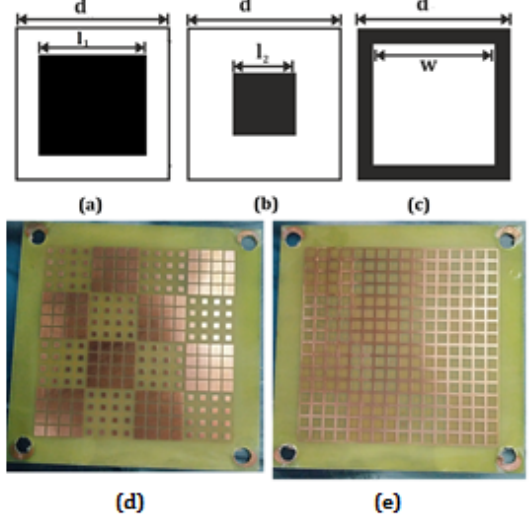
Figure.4. Superstrate structure details (a) AMC-unit cell I (top) (b) AMC- unit cell II (top) (c) AMCs unit cell (bottom) (d) fabricated prototype top view (e) bottom view (d= 5 mm, l = 4.1 mm, l = 2 mm, w= 4 mm) 1 2